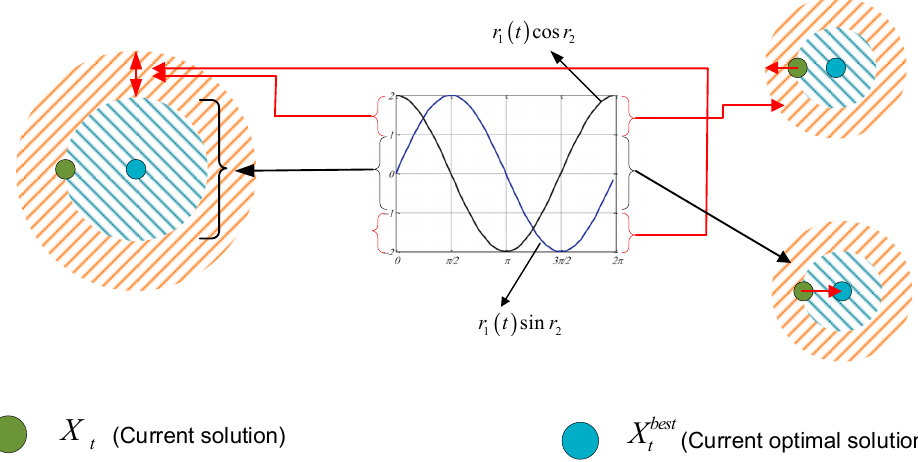
Figure 2. The optimization process of the SCA. Algorithm 1 Standard sine cosine algorithm